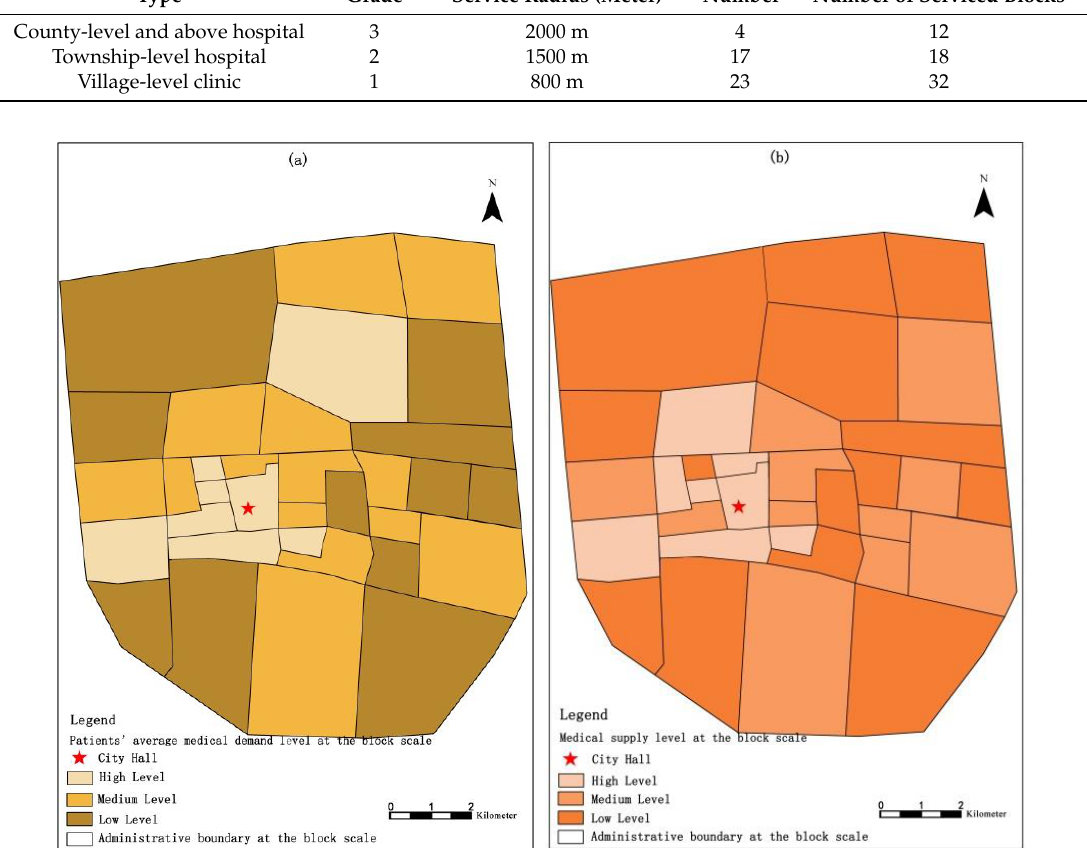
Figure 4. Residential agglomeration level ( a ) and medical supply level ( b ) in block units